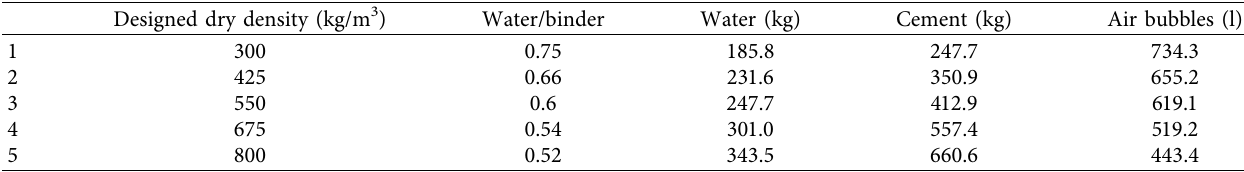
Table 2: Mix proportions and major parameters of the foamed concrete.